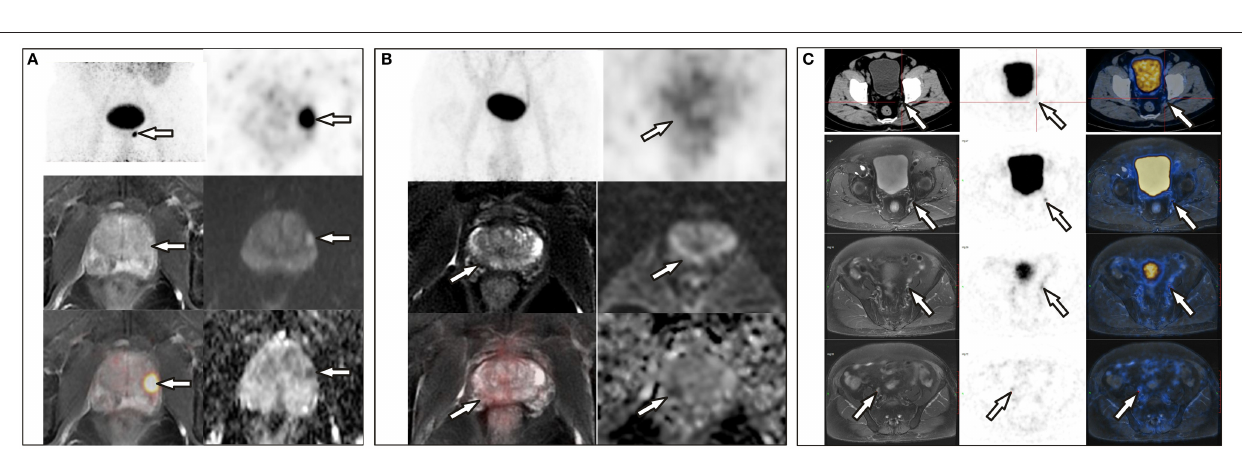
FIGURE 2 | (A) A 72-year-old man with a PSA level of 21.26 ng/L underwent 68 Ga-PSMA PET/CT and delayed pelvic PET/MR. Positive PSMA uptake was revealed in the left peripheral zone, consistent with the signal change in mpMR. (B) A 68-year-old man with proven prostate cancer in the right lobe underwent PET/MR for staging. Axial T2-weighted image shows an ill-defined hypointense lesion in the right peripheral zone with corresponding hypo-intensity on the apparent diffusion coefficient map. No significant hyperintense signal was observed on DW images ( b = 1,000 s/mm 2 ). This was assigned a PI-RADS score of 4, but negative PSMA uptake was observed with diffuse 68 Ga-PSMA uptake in the prostate (SUVmax, 4.10). (C) A 71-year-old man with proven prostate cancer after prostate transurethral resection, 68 Ga-PSMA PET/CT and pelvic PET/MR were performed for staging. PET/CT revealed only one small lymph node in the left pelvic cavity, which